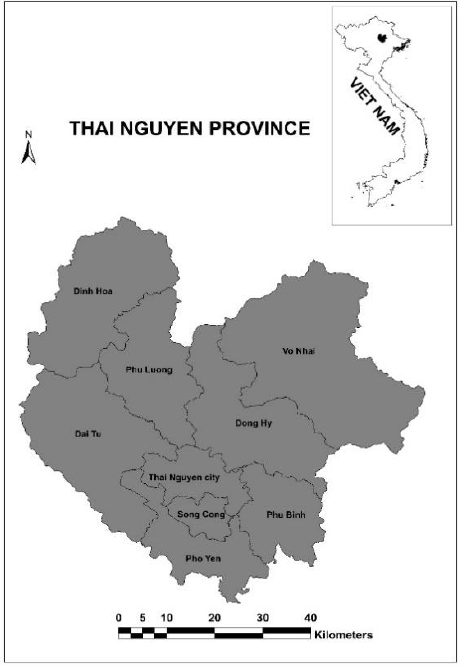
Figure 1. Map showing the study area.